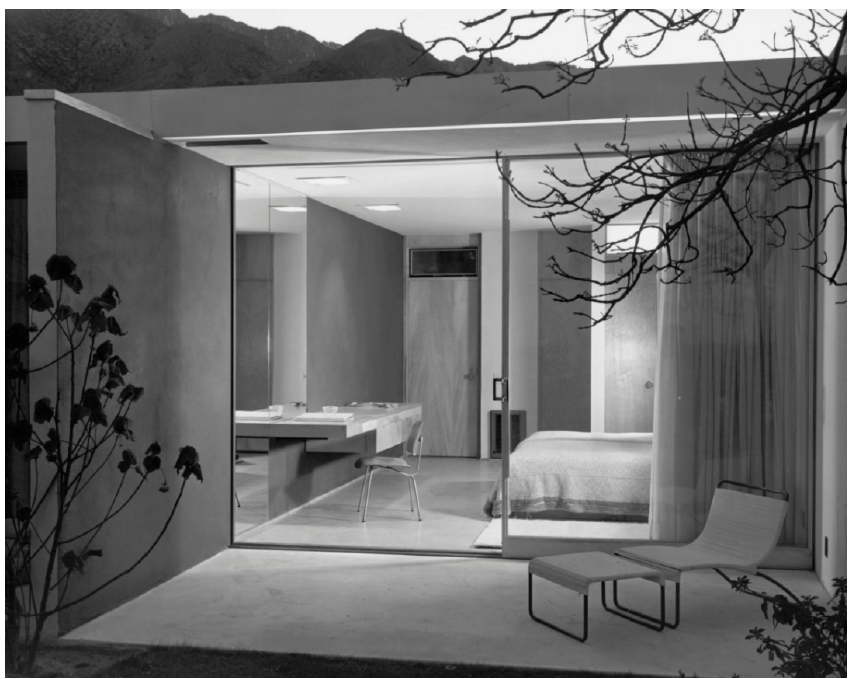
Figure 7. Richard Neutra, Kaufmann Desert House, Palm Springs, 1946–1947. Guestroom #2. (Photo by Julius Shulman, job 093-27, © J. Paul Getty Trust. Getty Research Institute, Los Angeles, 2004.R.10).